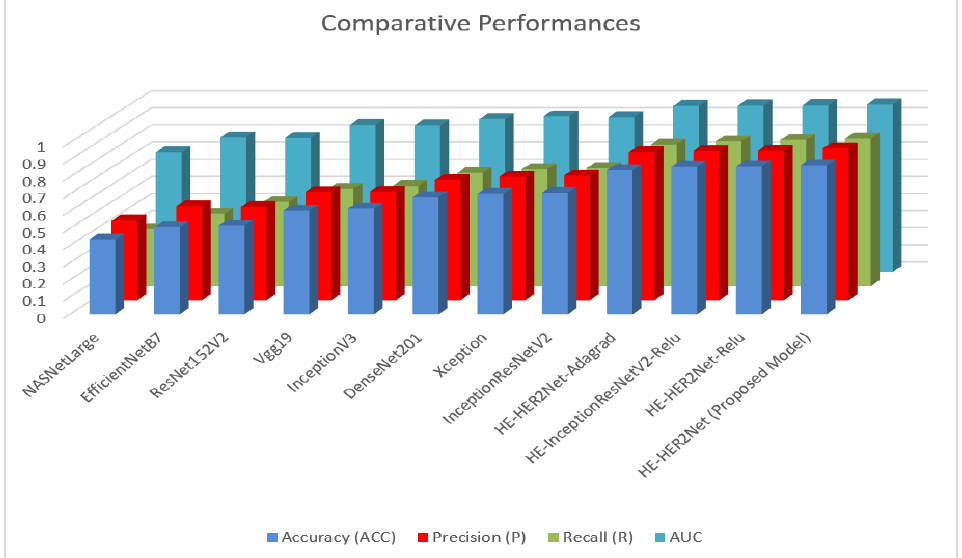
Figure 5. This column chart briefly describes comparative performances among all models. ‘HE- HER2Net’ is the proposed